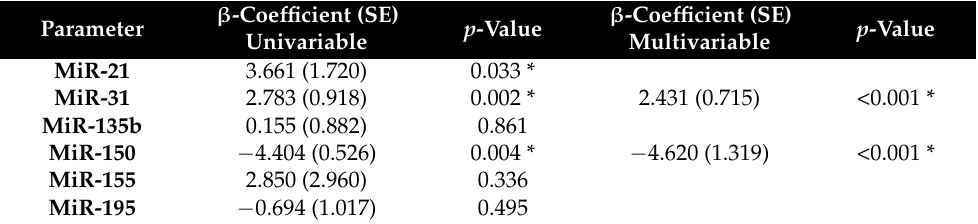
Table 4. Logistic regression univariable and multivariable analyses were used to determine the predic- tive role of miRNA targets in differentiating tumour samples from tumour-associated normal samples.